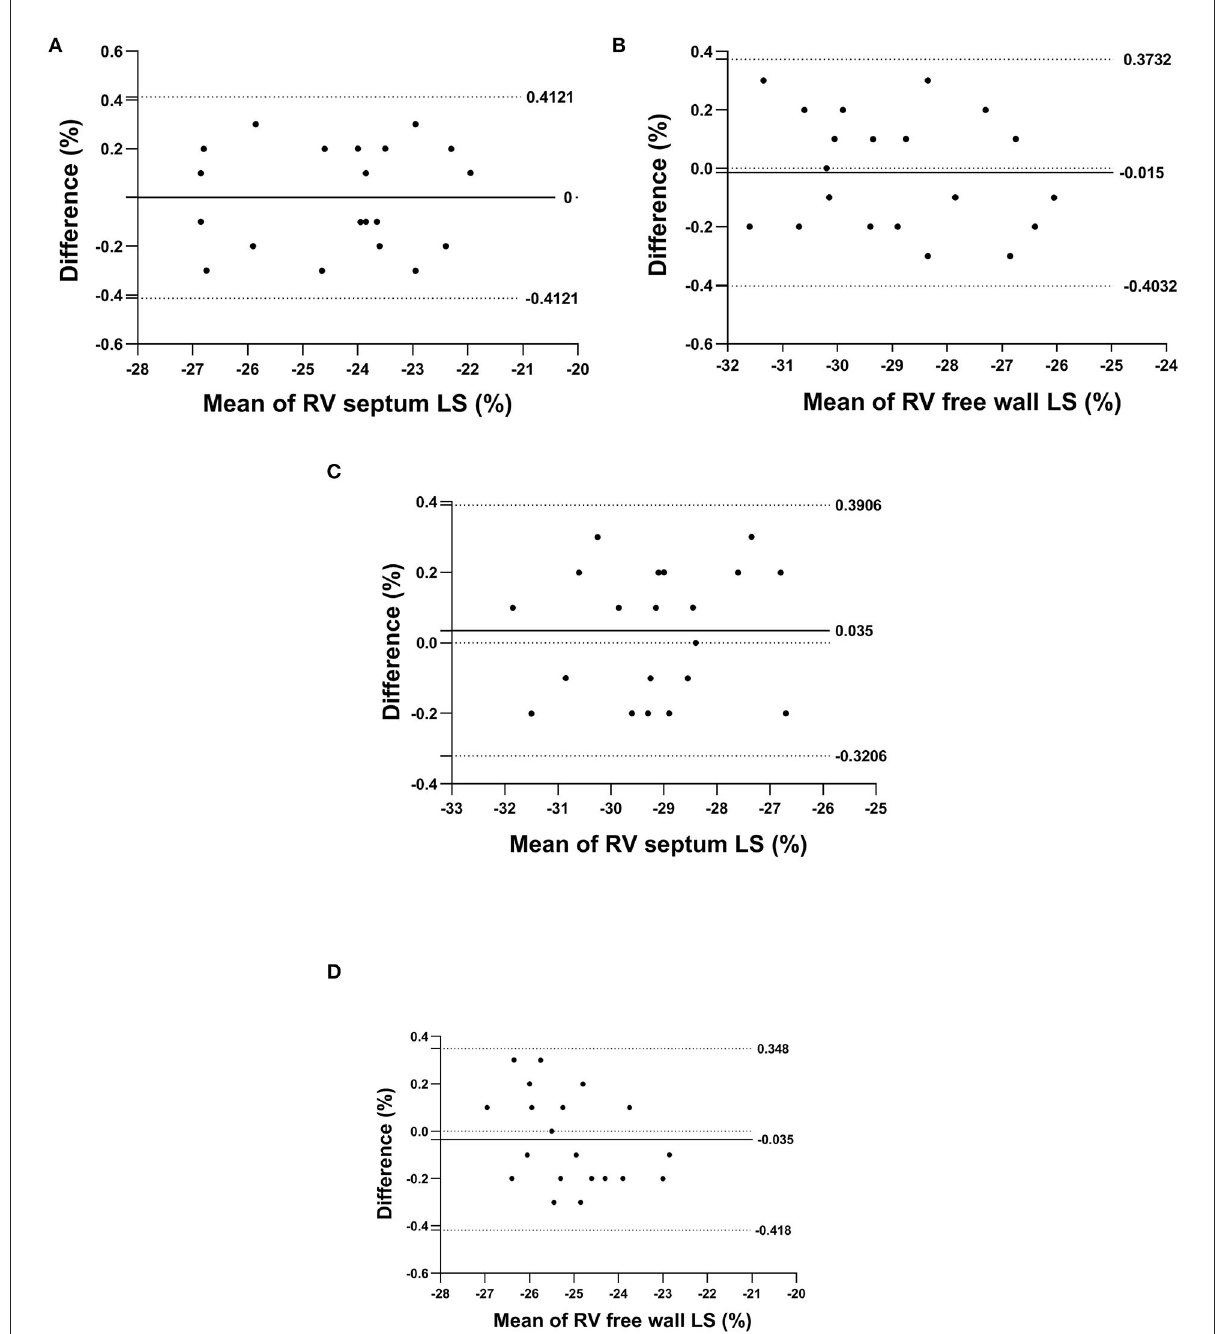
FIGURE2 The Bland–Altman plot for repeated measurements of the right interventricular septum longitudinal strain and right ventricular free wall longitudinal strain; (A,B) denote the intra-observer agreement analyses, respectively, and (C,D) denote the inter-observer agreement analyses,